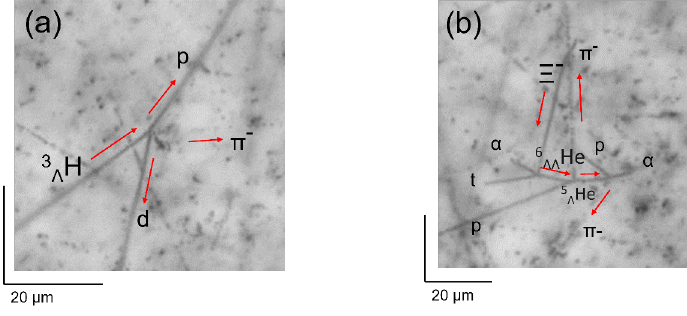
Figure 1. Artificial microscopic images of (a) a 3 Λ H → p + d + π − decay event and (b) a 6 ΛΛ He decay